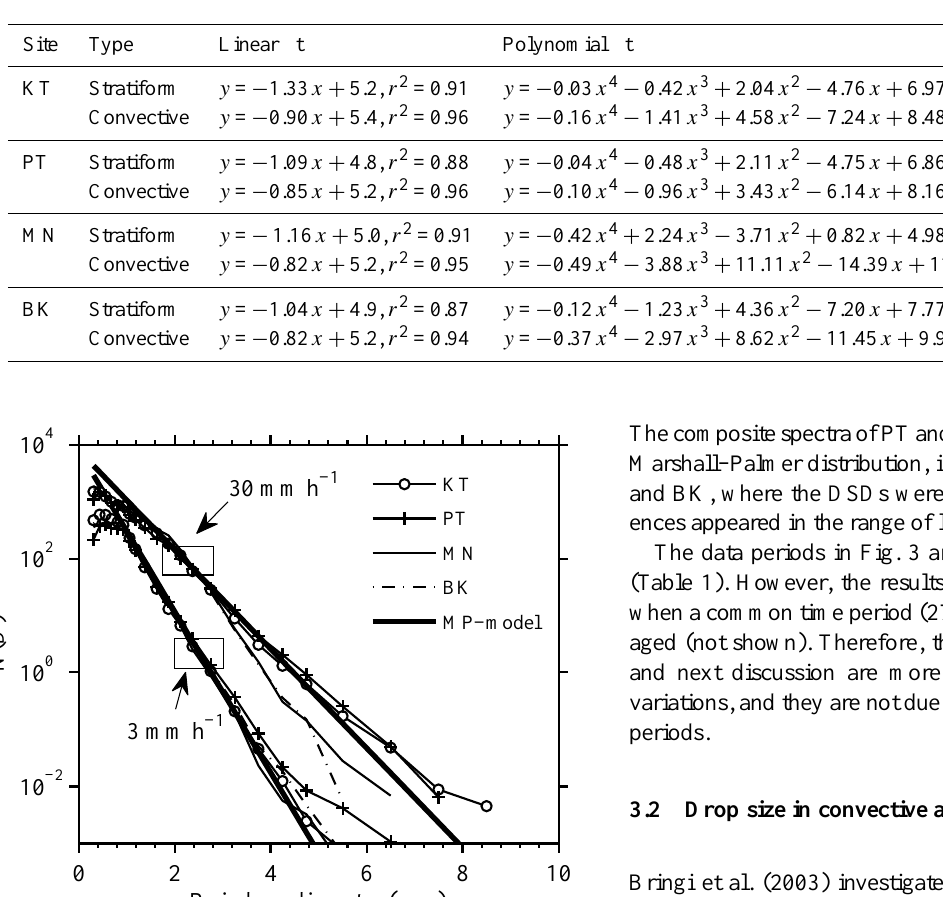
Table 2. Relations between log 10 (N w ) and D m for the data in Fig. 4a–d. Max and min indicate maximum and minimum values of D m for the fitting process.